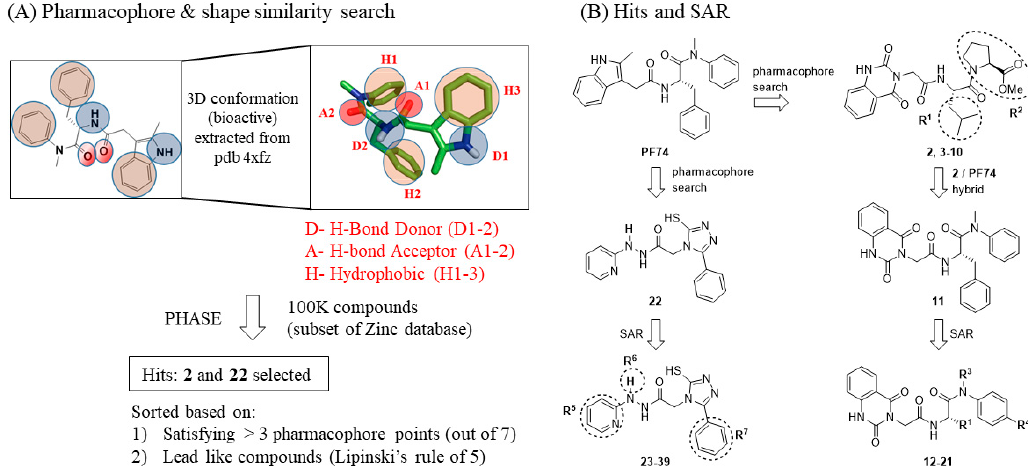
Figure 2. Generation of novel compounds targeting the PF74 binding pocket. ( A ) Initial hits generated via a pharmacophore and shape similarity search; ( B ) SAR of two selected hits ( 2 and 22 ), as well as a new hit ( 11 ) from the hybridization between 2 and PF74 . Compounds 3–10 are variants of 2 , with modifications in the circled